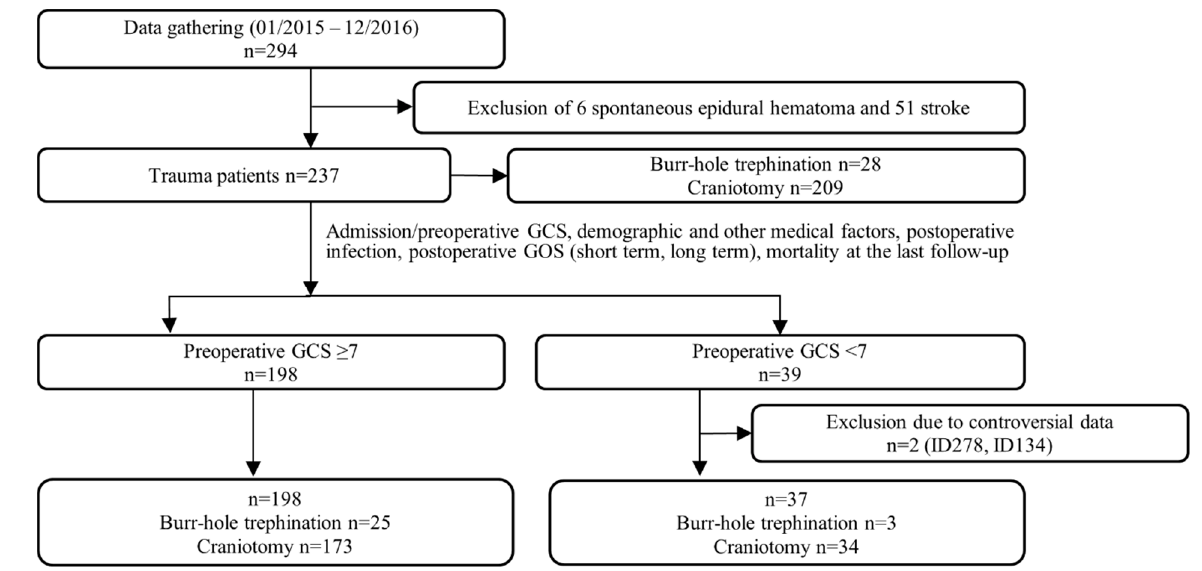
Figure 1. Flowchart of the process of data inclusion and exclusion for statistical analysis. Overview of the process of extracting data for the study patient of interest. Abbreviations: GCS, Glasgow Coma Scale; GOS, Glasgow Outcome Scale; ISS, Injury Severity Score.